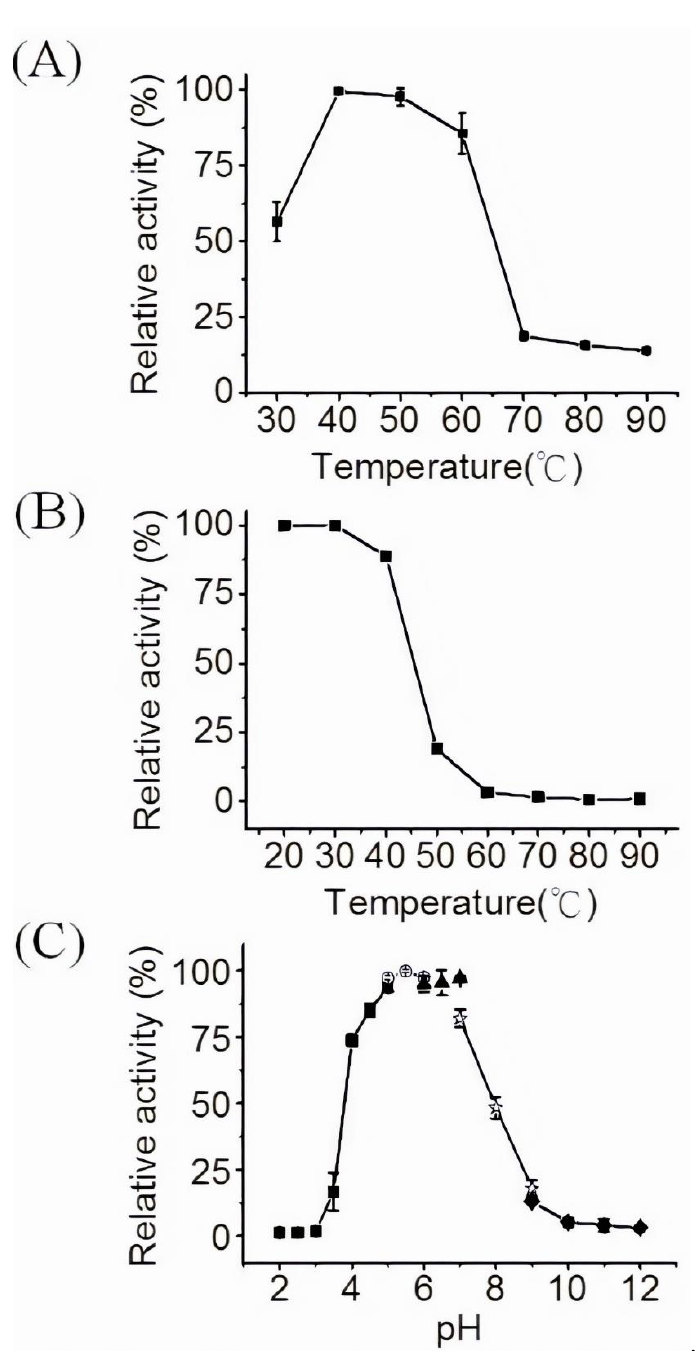
Figure 3. Optimization of chitinase 1198 activity by using p-NP-(GlcNAc)2 as a substrate. ( A ) Effects of temperature on chitinase 1198 activity. Chitinase activity was determined at different temperatures (30 to 90 °C). ( B ) Thermostability of chitinase 1198 was determined at different temperatures (20 to 90 °C). ( C ) Effects of pH on chitinase 1198 activity. Chitinase activity was determined under different pH conditions. Symbols: black squares = sodium citrate (pH = 2.0–5.0); open circles = sodium phosphate (pH = 5.0–6.0); black triangles = MES (pH = 6.0–7.0); open stars = Tris-HCl (pH = 7.0–9.0); black diamonds = glycine-NaOH (pH =